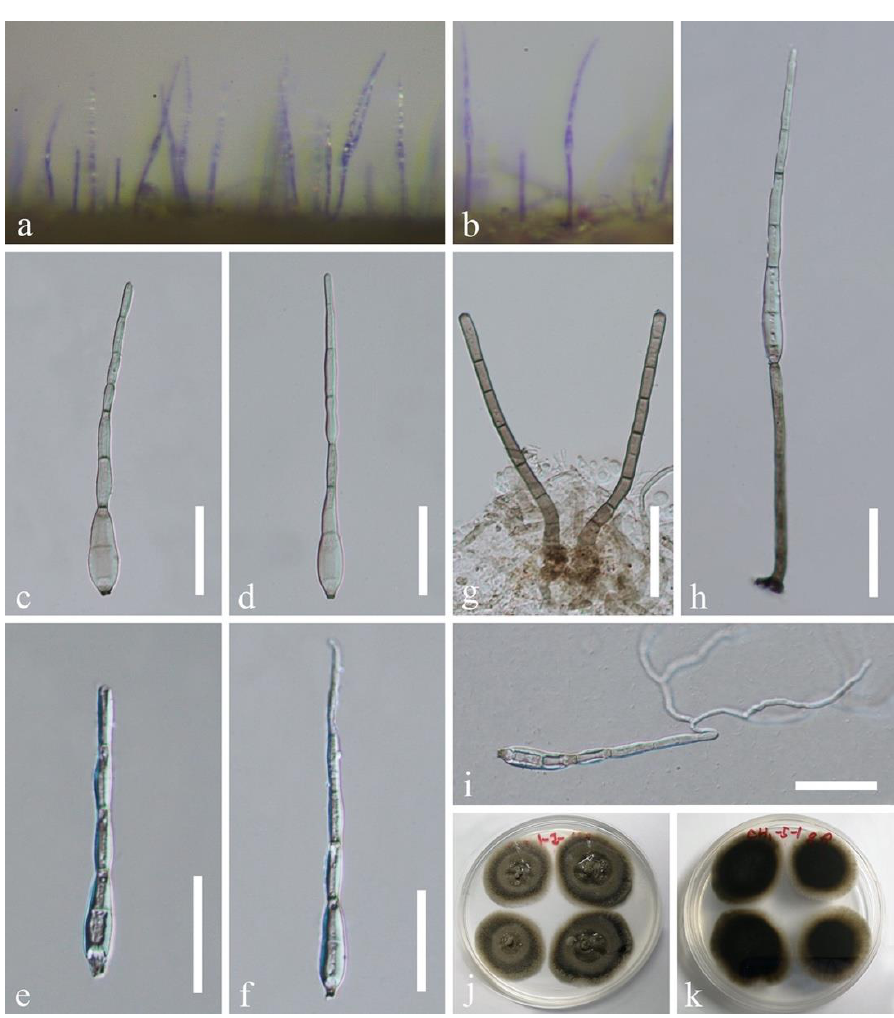
Figure 7. Distoseptispora lignicola (GZAAS20-0424). ( a , b ) Colonies on natural substrate. ( c – f ) Conidia. ( g ) Conidiophores. ( h ) Conidiophore and a conidium. ( i ) Germinated conidium. ( j , k ) Culture, j from above, k from below. Scale bars: ( c – i ) 30 μ m. Distoseptispora verrucosa J. Yang and K.D. Hyde, sp. nov., Figure 8.